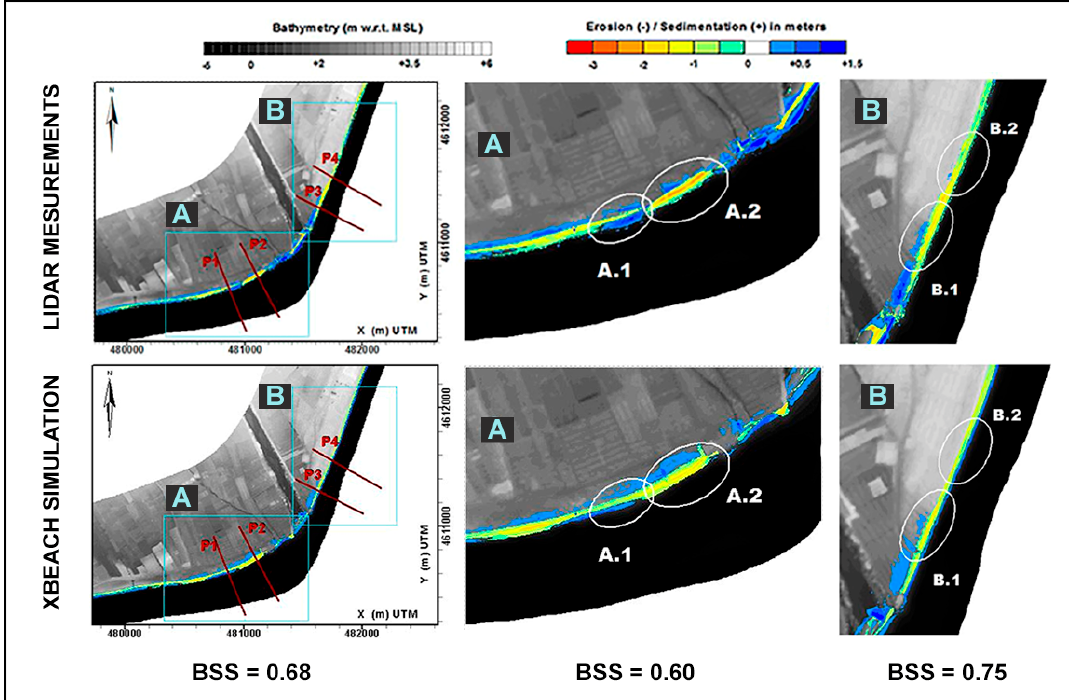
Figure 5. XBeach validation with LIDAR measurements of the emerged morphological changes. BSS: Brier Skill Score.